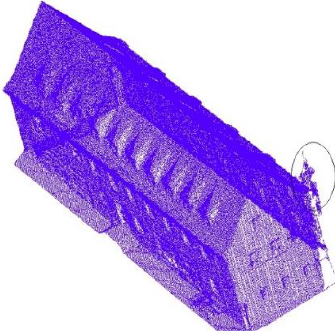
Figure 1. Point cloud of a single building